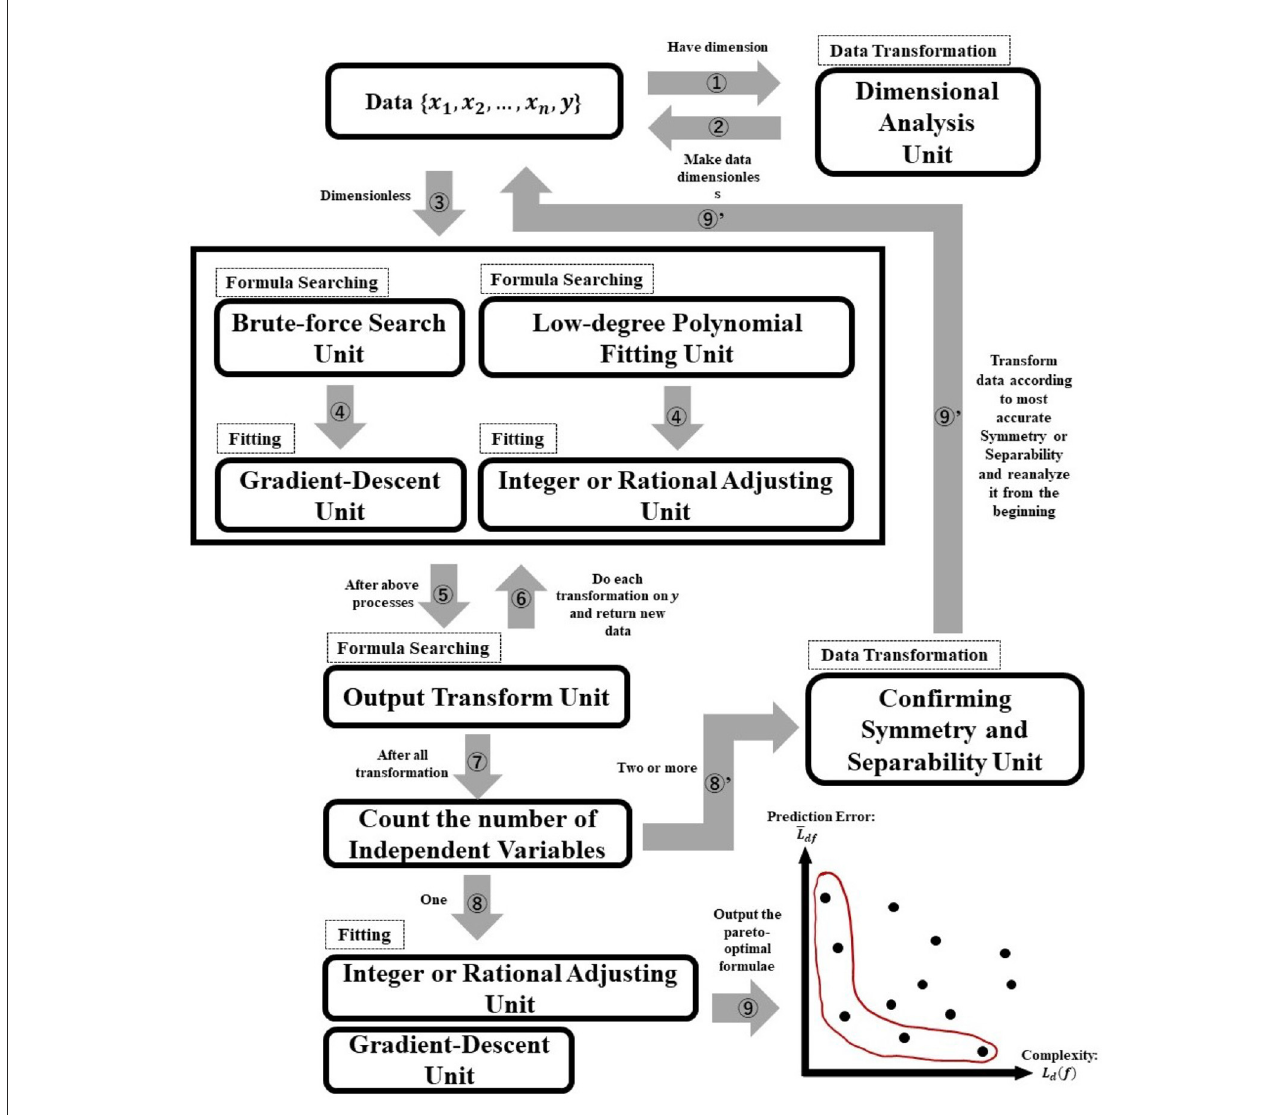
FIGURE2 Overview of AI-Feynman’s